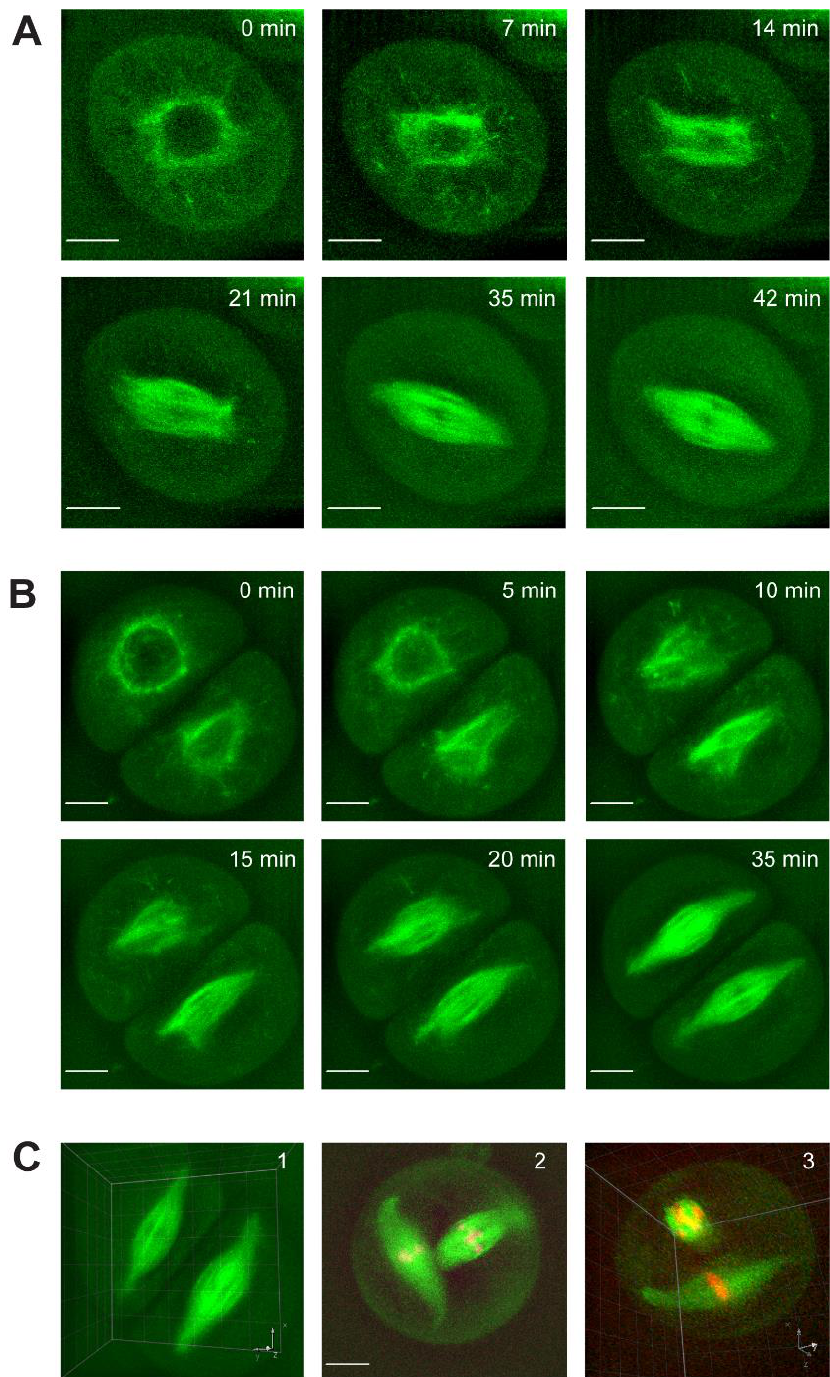
Figure 1. Live assembly of male maize meiosis I and meiosis II spindles. Live assembly of meiotic spindles were imaged using CFP-tubulin (β-TUB1) to label microtubules (green). The cell volume can be seen due to visible diffuse unincorporated CFP-tubulin monomers in the cytoplasm. ( A ) Example movie of meiosis I spindle assembly. ( B ) Example movie of meiosis II spindle assembly. ( C ) A single spindle forms in each meiosis II cell, but assembly results in spindles oriented parallel to each other (panel 1). Of all imaged cells ( n = 75 total), only a single instance of non-parallel meiosis II spindles was observed (panel 2). Viewed in 3D, the spindles can be seen in a perpendicular orientation (panel 3); a cross-sectional view of the top spindle is seen in panel 3 as the 3D orientation is looking down the length of the spindle. Chromosomes are shown in magenta in panel 2 and Scale bars: 10 µm.